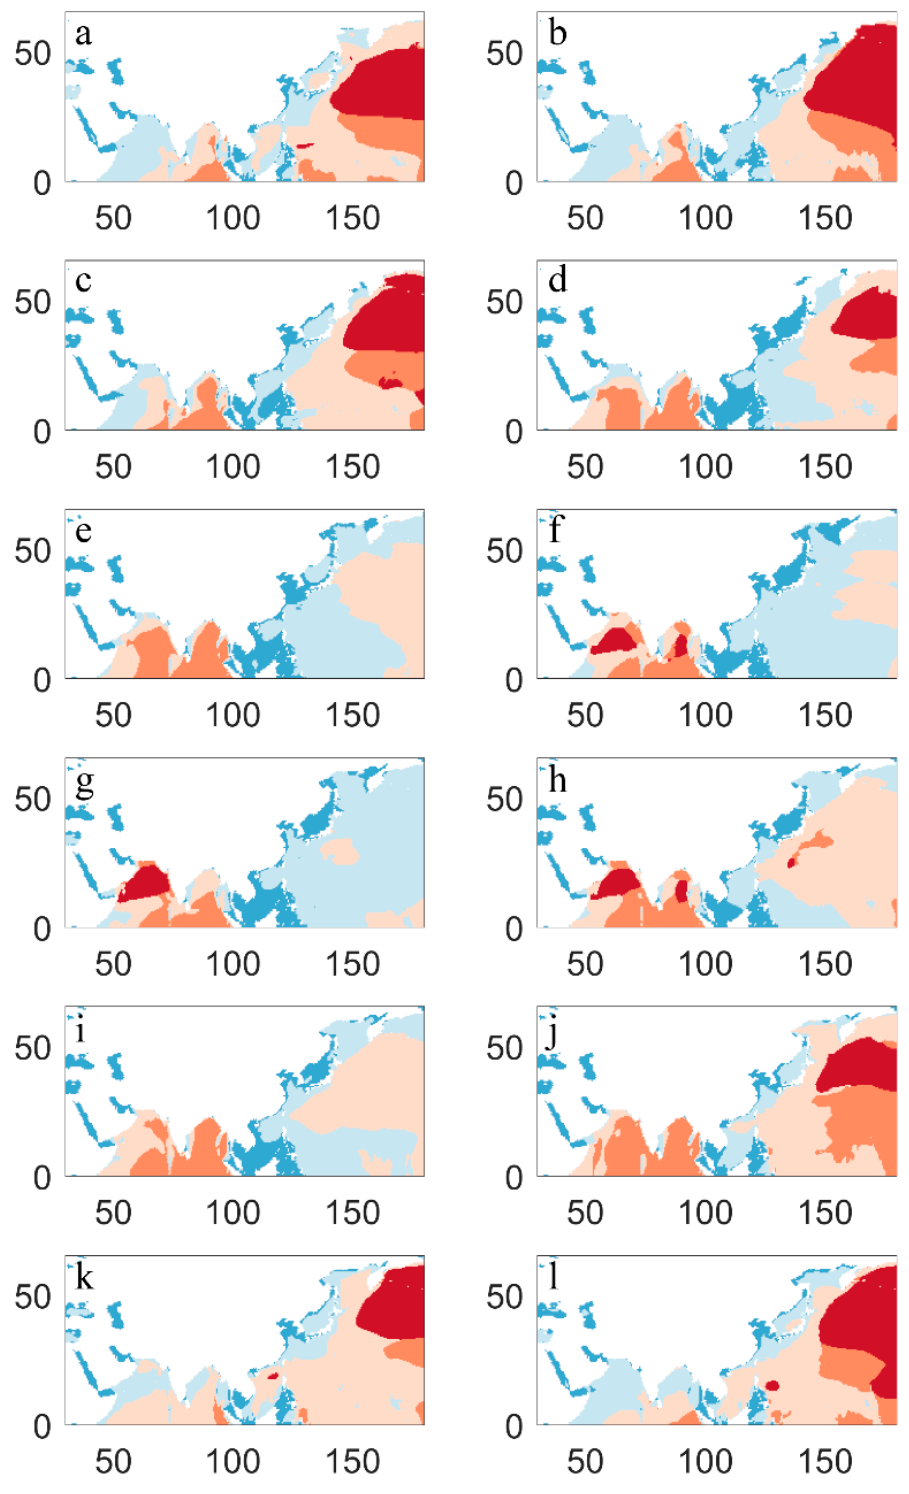
Figure 4. Wave classification in each month: ( a ) January, ( b ) February, ( c ) March, ( d ) April, ( e ) May, ( f ) June, ( g ) July, ( h ) August, ( i ) September, ( j ) October, ( k ) November, and ( l ) December. In Figure 3, “ × ” represents each cluster center. The data values for each cluster center are shown in Table